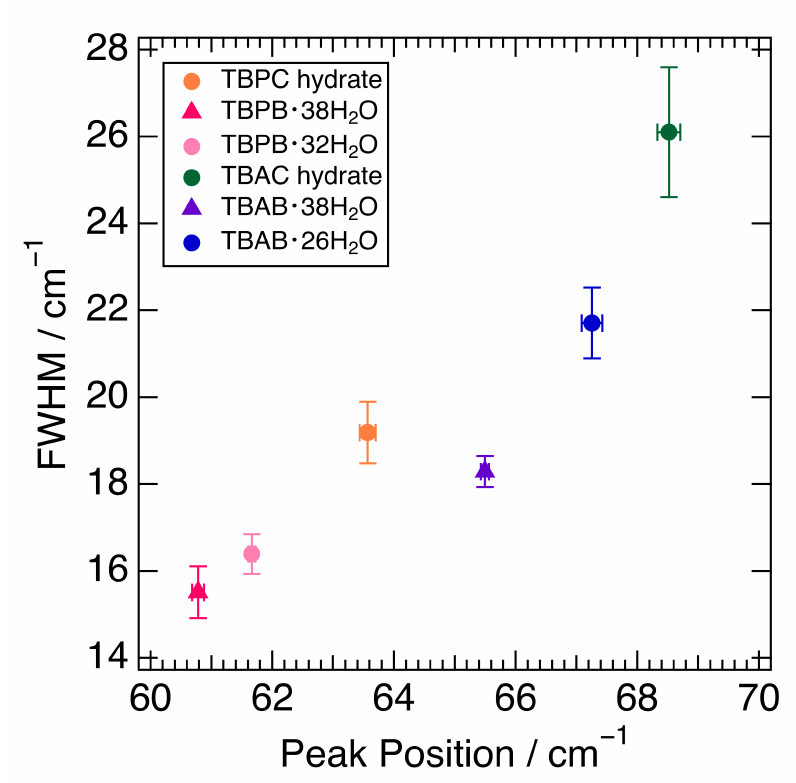
Figure 3. Relationship between peak position and FWHM in six semi-clathrate hydrates. Markers are explained in the